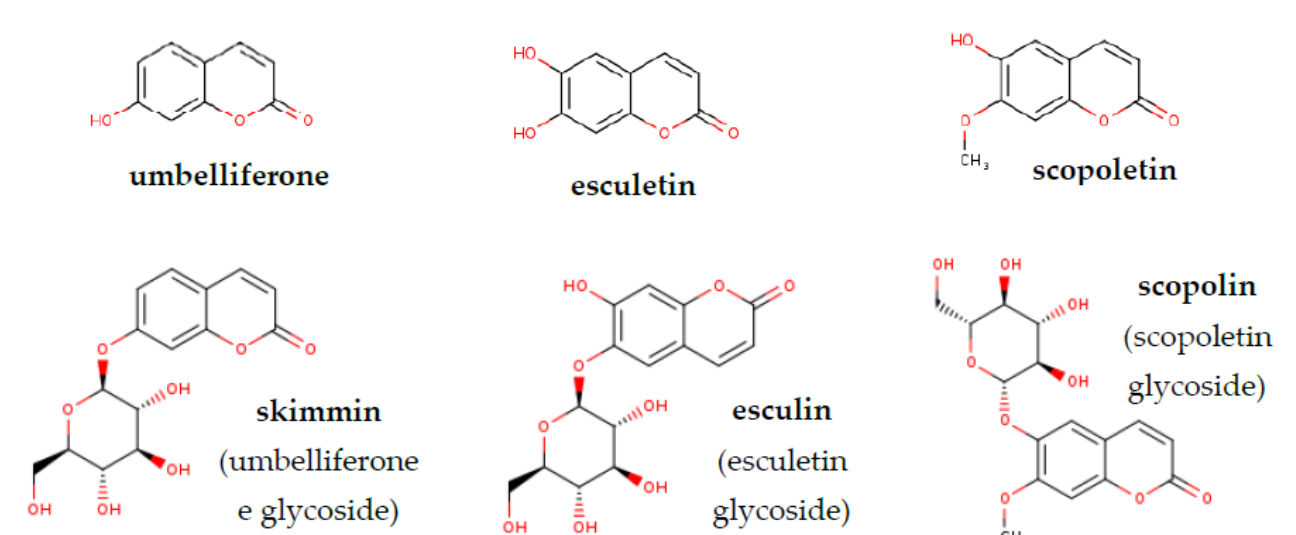
Figure 1. Chemical structures of simple coumarins and their glycosides analysed in this work (www.chem-space.com (accessed on 20 January 2021)).